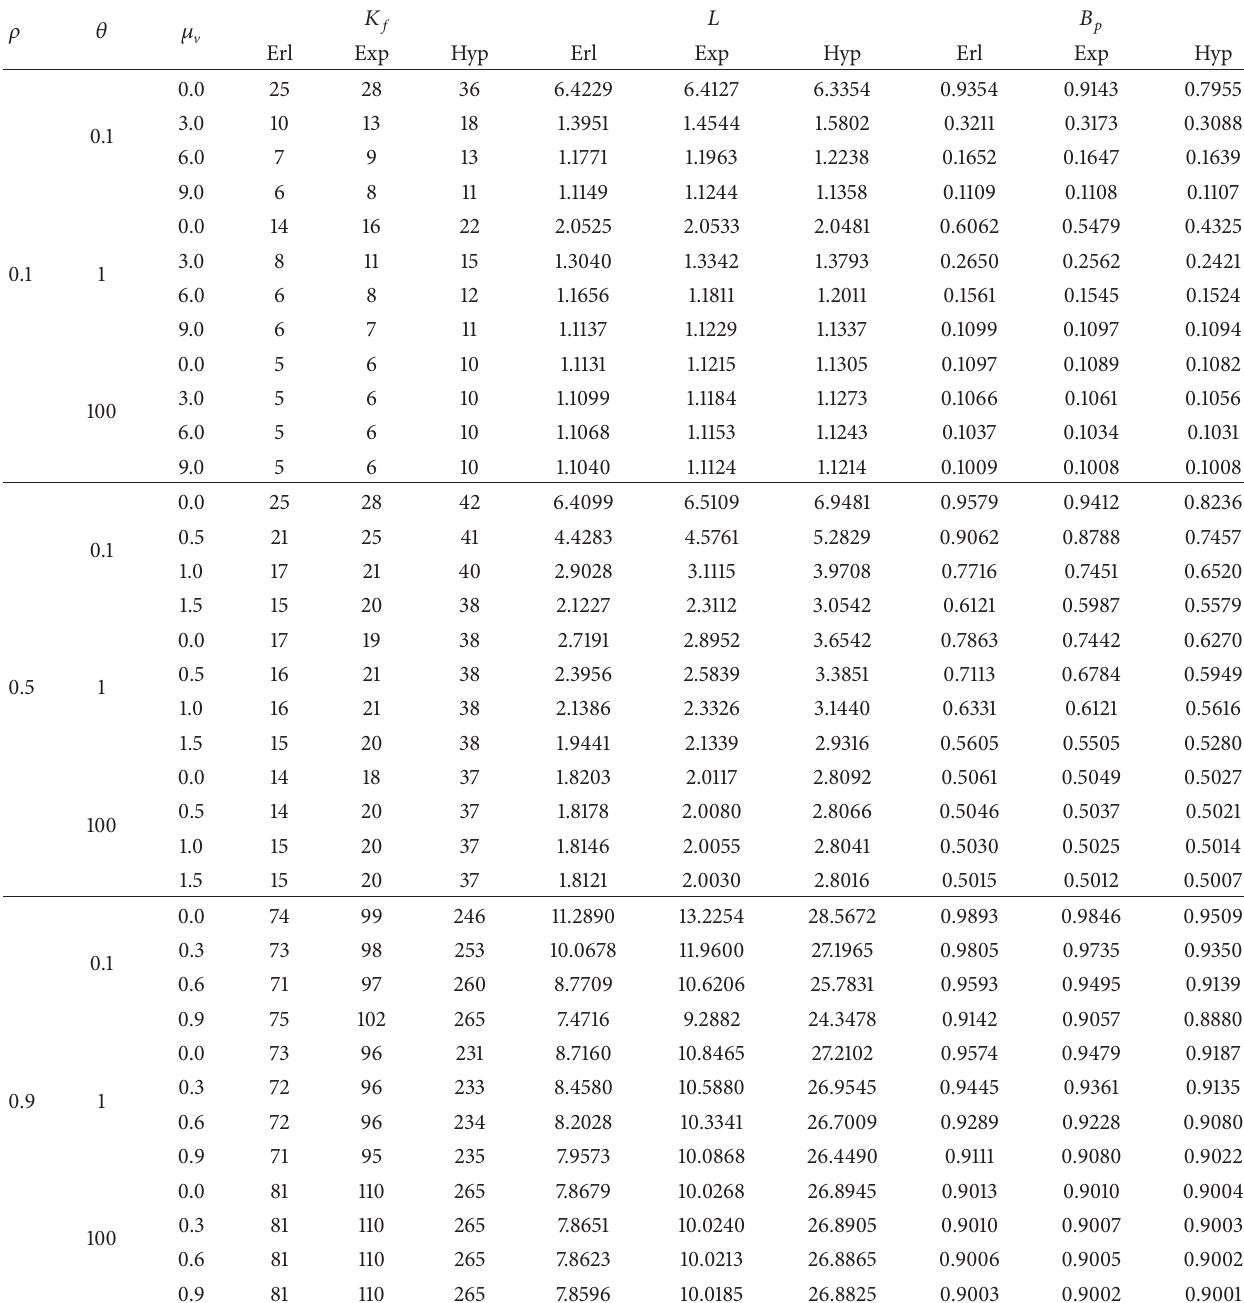
Table 1: Multiserver model with 𝑐 = 1